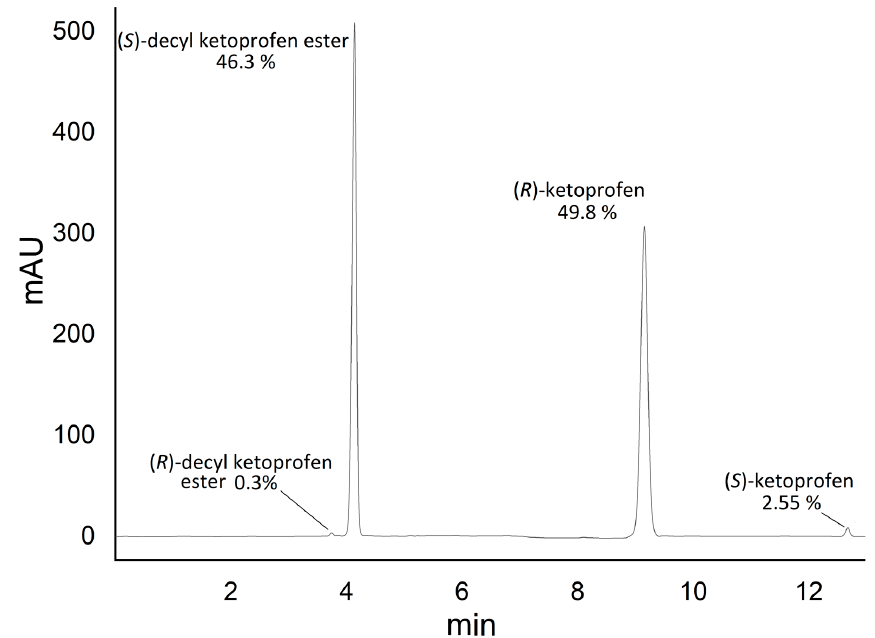
Figure 2. HPLC chromatogram of an esterification reaction at 48 h.